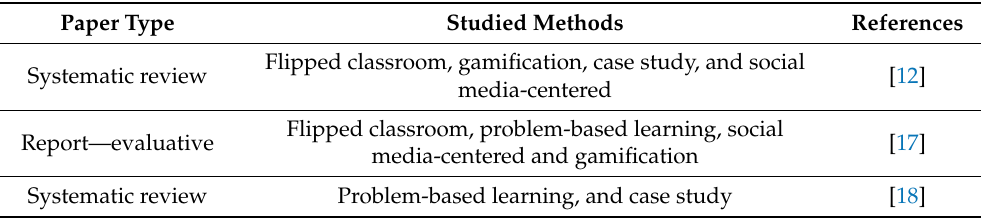
Table 1. Articles that met inclusion and quality